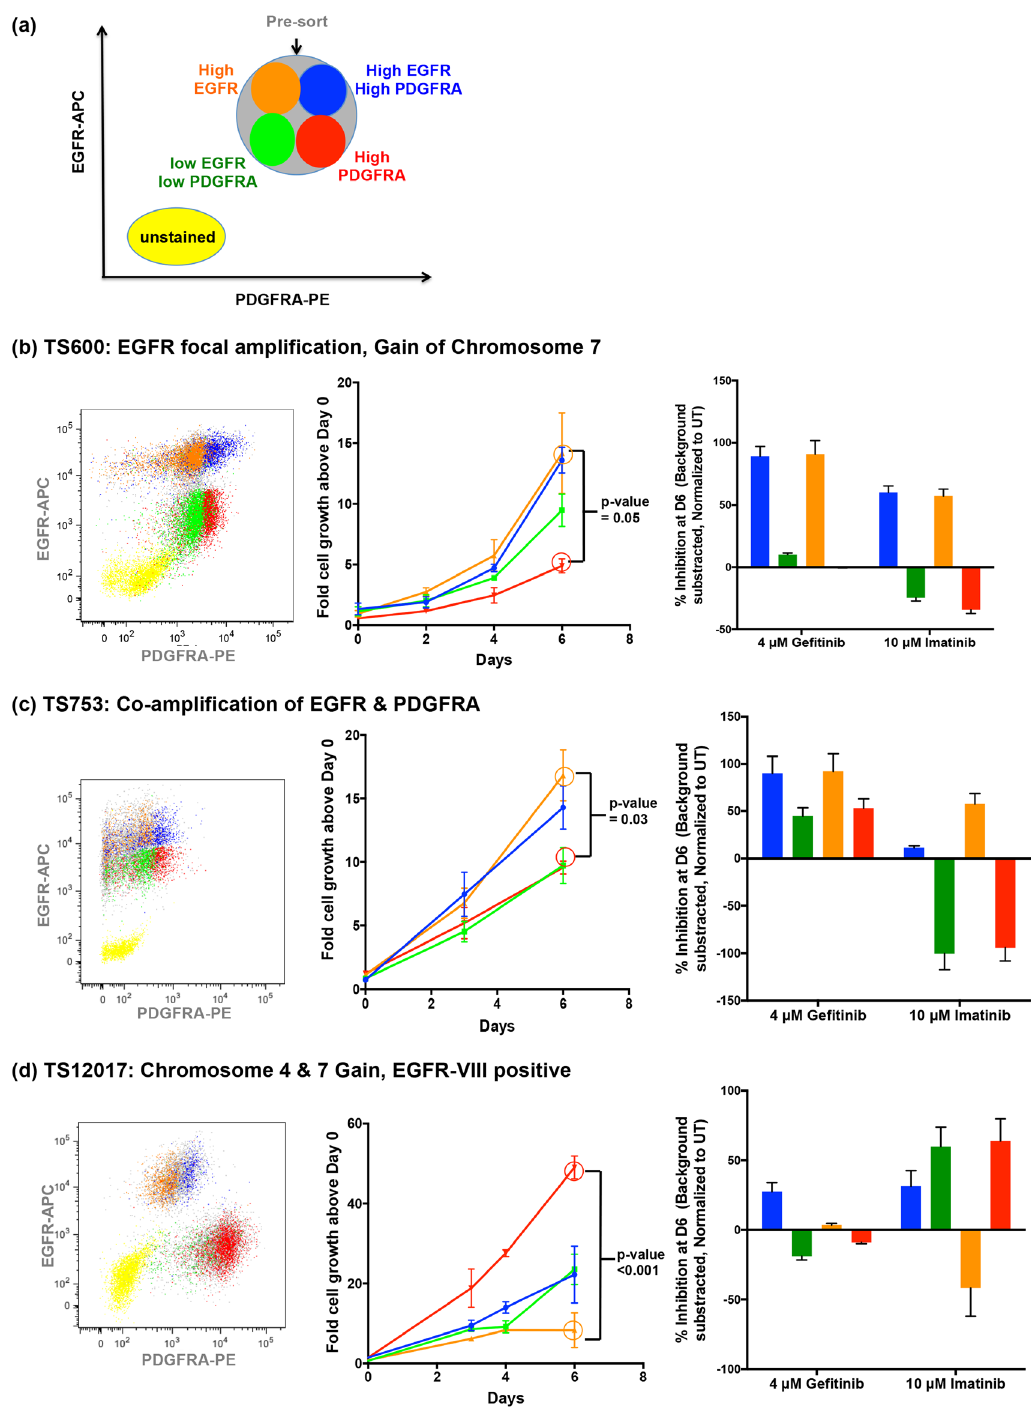
Figure 5. Heterogeneity of response to targeted therapies occurs as a function of the balance of RTK expression in primary GBM samples. ( a ) Patient derived glioblastoma lines were viably sorted for EGFR and PDGFRA surface immunopositivity (cells with relatively higher EGFR and PDGFRA co-expression = blue. EGFR = orange, PDGFRA = red and cells with relatively lower EGFR and PDGFRA co-expression = green). ( b – d ) Left panels: Verification of relative RTK-expression by post-FACS re-sort analysis. Center panels: RTK- expression defined subpopulations were individually cultured for 6 days and their comparative growth rates were measured using the resazurin fluorometric assay. Right panels: Each subpopulation was treated for six days with either gefitinib or imatinib and their comparative growth were measured using the resazurin fluorometric assay on Day 6. Each bar represents measurement in triplicate, background (media only) subtracted and normalization to Day 0; ( b ) TS600, ( c ) TS753 ( d )